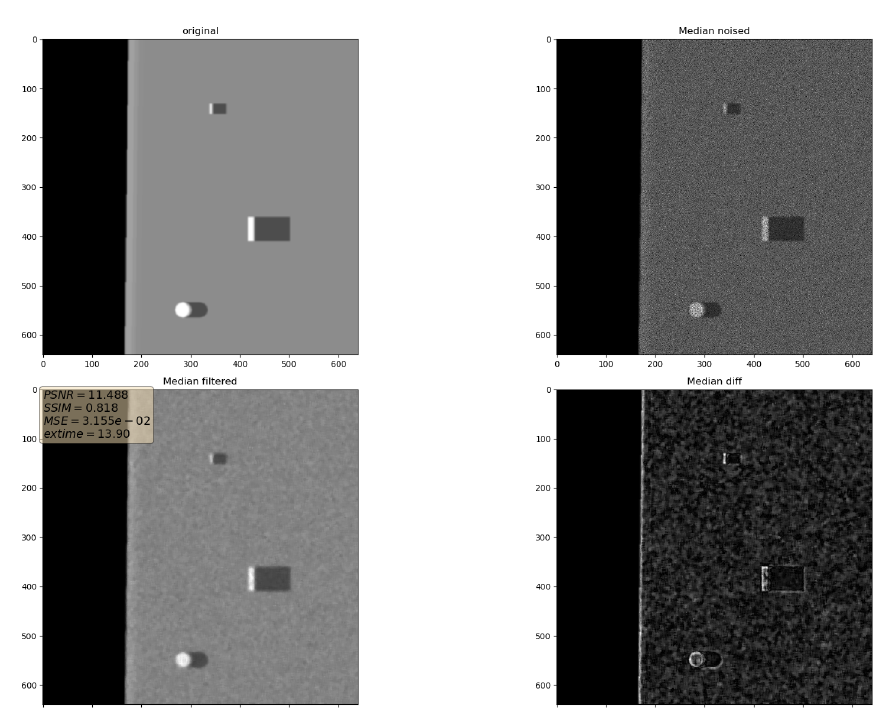
Figure 9. Filtering results for Median filter. Speckle noise σ 2 =